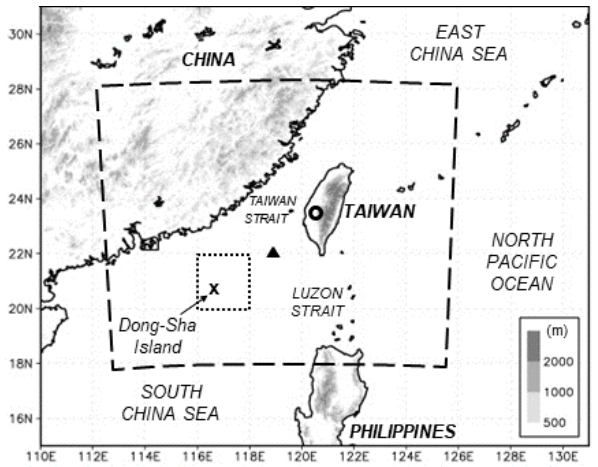
Figure 1. The geography and topography (m, shading) surrounding Taiwan. The dashed lines show the CReSS model simulation do- main, and the locations of Dong-Sha Island (cross), research vessel (triangle), and the reference point of the idealized initial and bound- ary conditions (open circle, at 23.5 ◦ N, 120.5 ◦ E) are all marked. The dotted box depicts the 2 ◦ × 2 ◦ area surrounding Dong-Sha used to compute mean